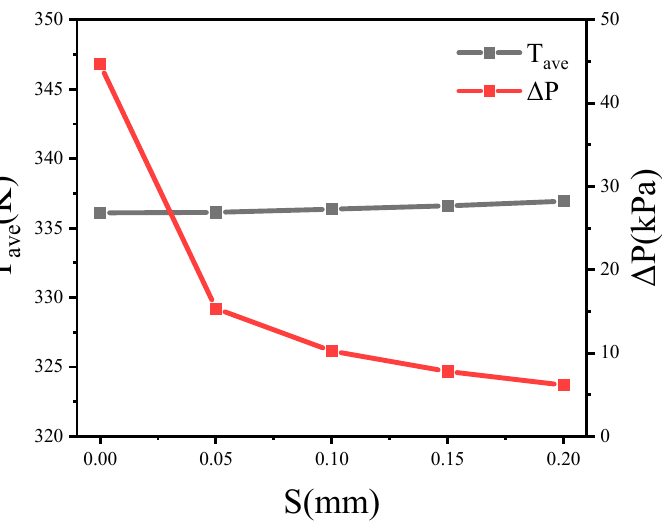
Figure 12. The average temperature and pressure drop of the heat source with different spacing of the cross-ribs.